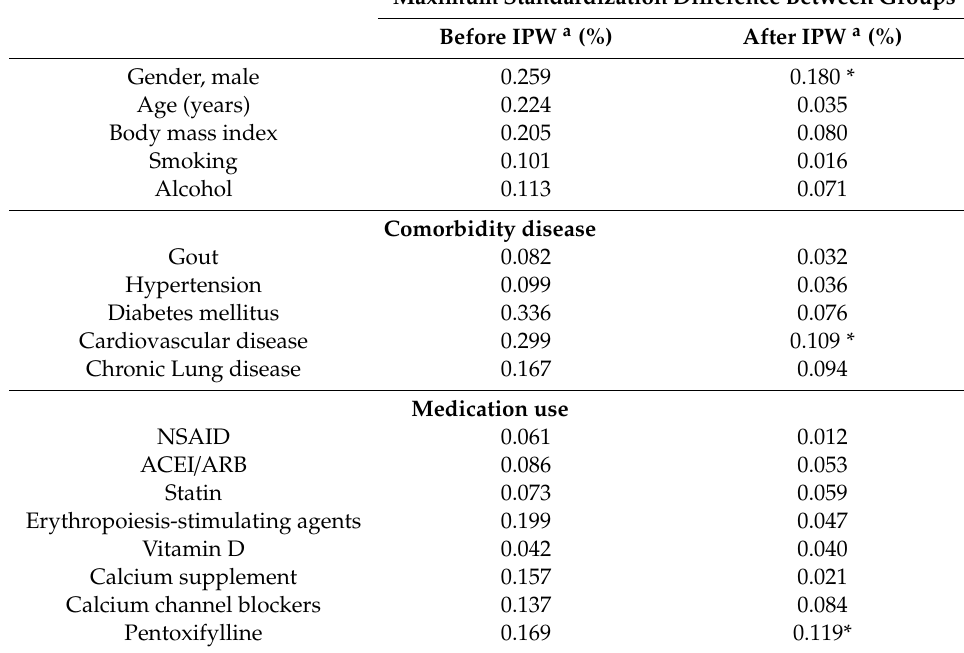
Table 4. Covariate balance between AGR categories before and after inverse probability of treatment weighted